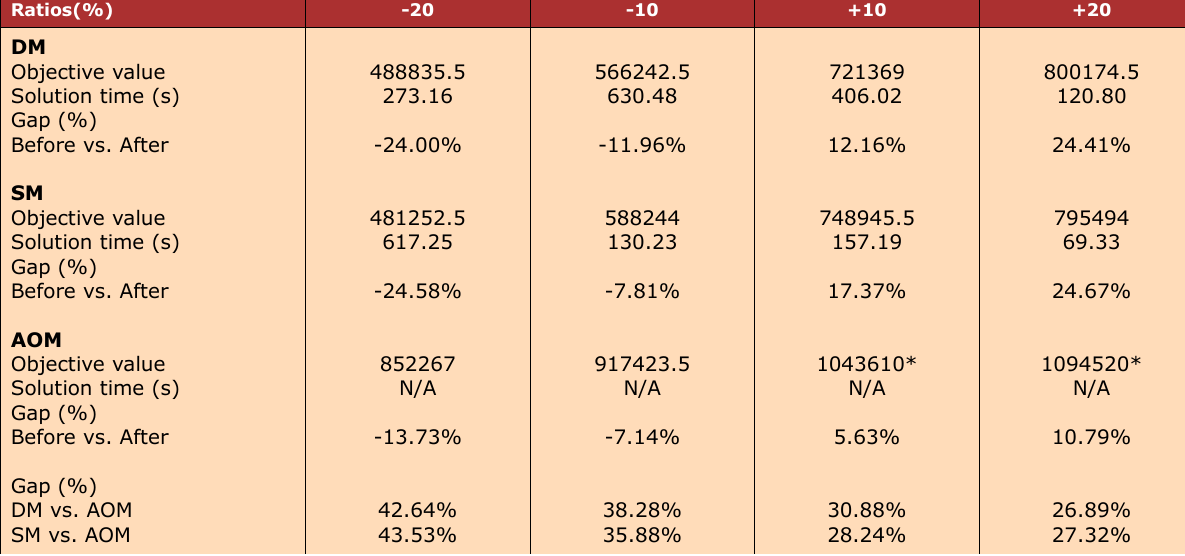
Table 2. Sensitivity analysis with the change of average